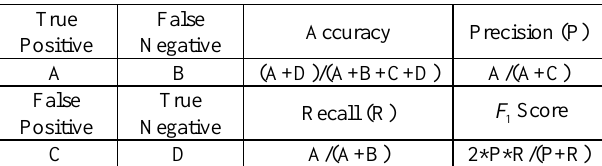
Table 1. Confusion matrix used in pointwise assessment of separation results